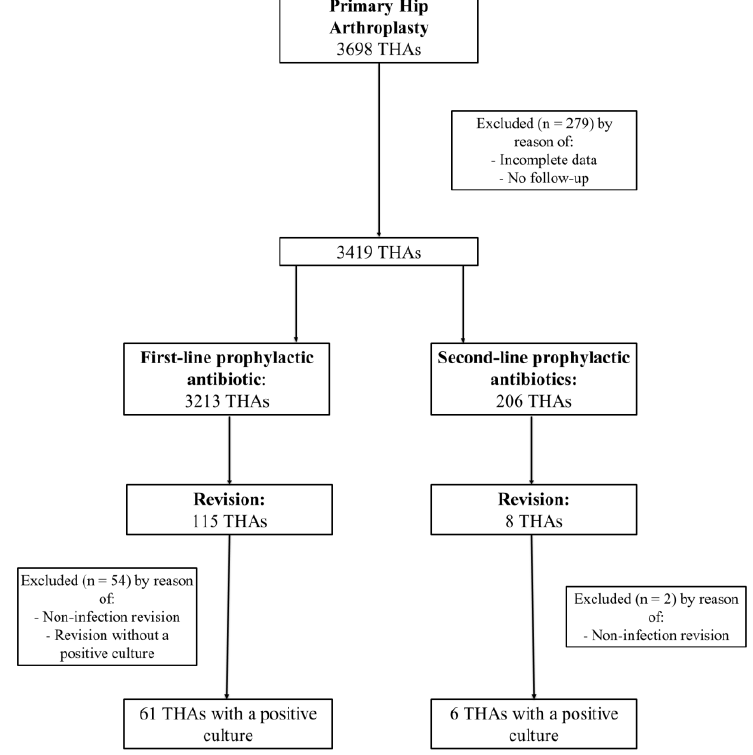
Figure 1. Flowchart of patients ’ inclusion criteria in THA group.